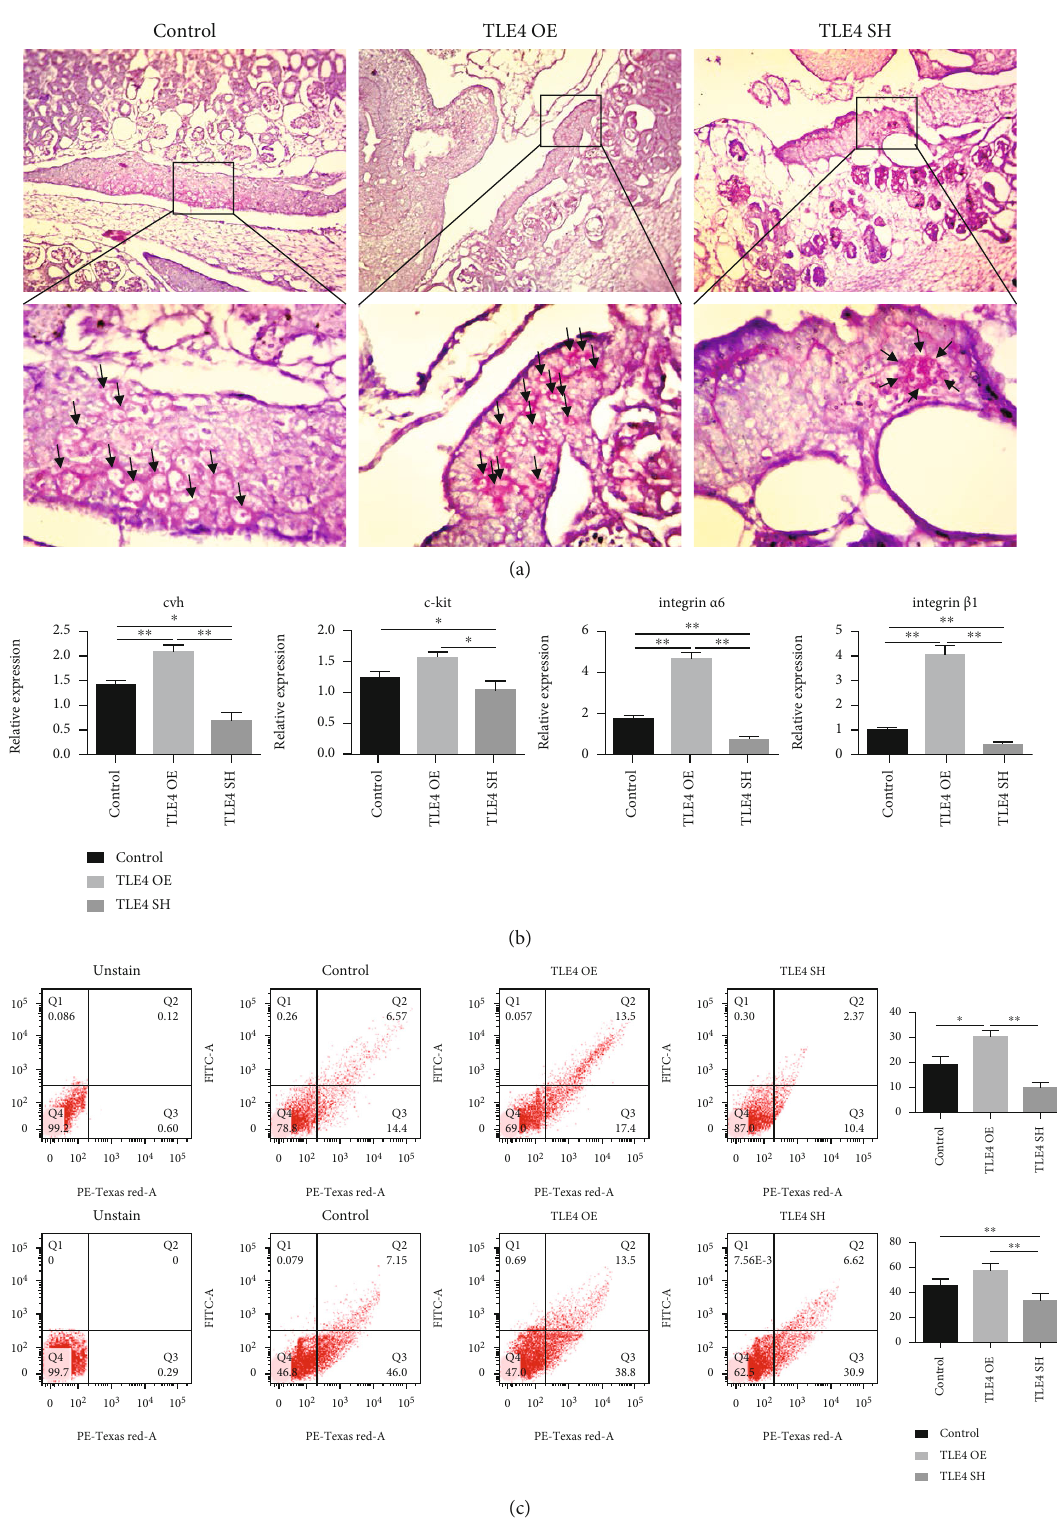
Figure 8: TLE4 function veri fi cation in vivo. (a) PAS staining of day 4.5 embryos, in the oval is the genital ridge; ↑ the arrows point to PGCs. (b) Marker genes were detected on day 4.5 genital ridge/day 18.5 testes. (c) Flow cytometry analysis on day 4.5 genital ridge/day 18.5 testes and quanti fi cation of positive